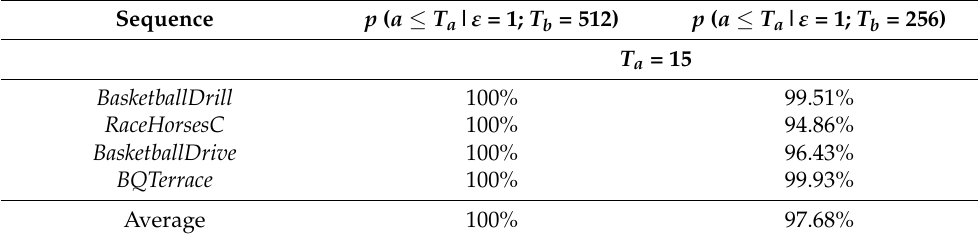
Table 2. Posterior probability with activity given ε (QP = 27).